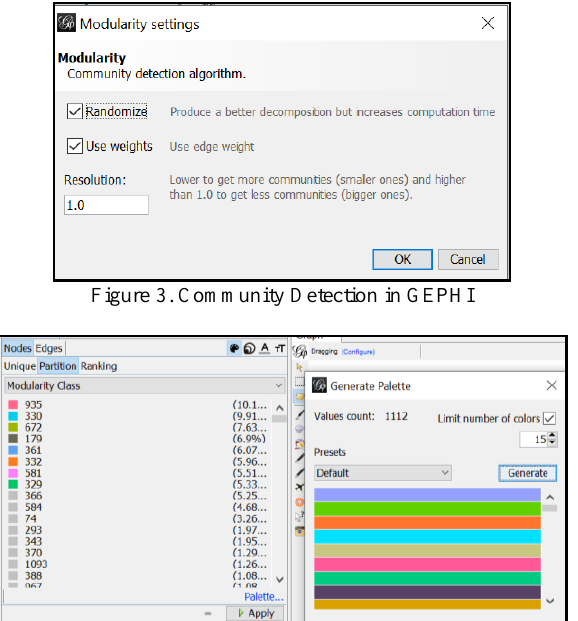
Figure 4. Generating color palette for top 15 modularity valued communities